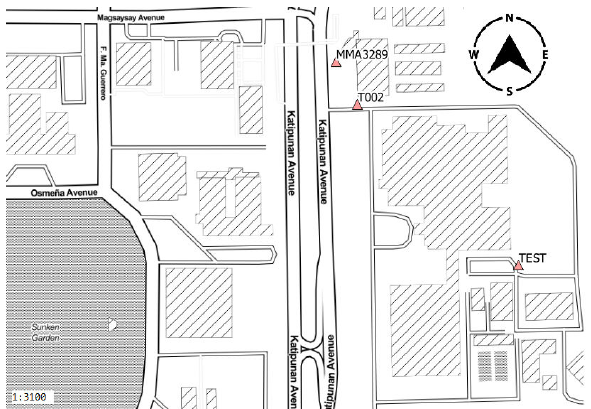
Figure 1. Location of study area, chosen because of its